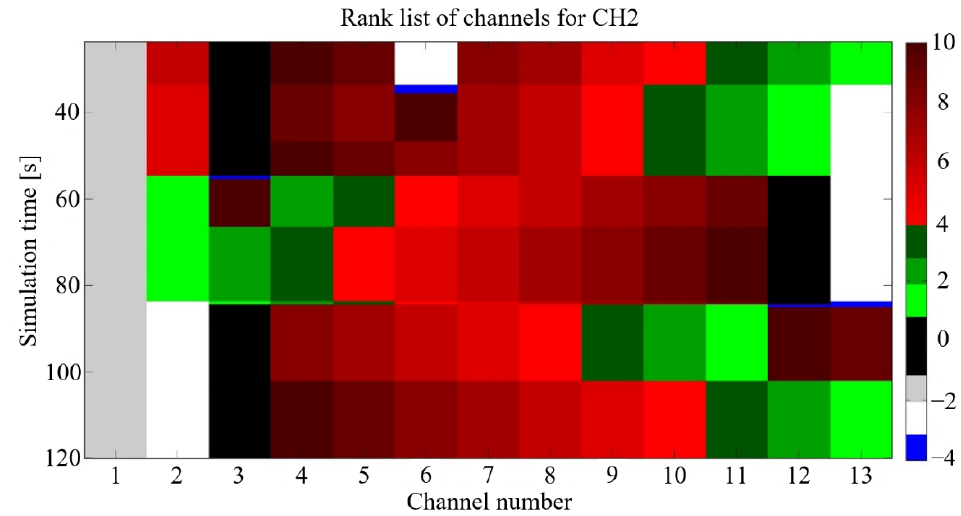
Figure 3. Simulation results with ranking list of channels—an example.